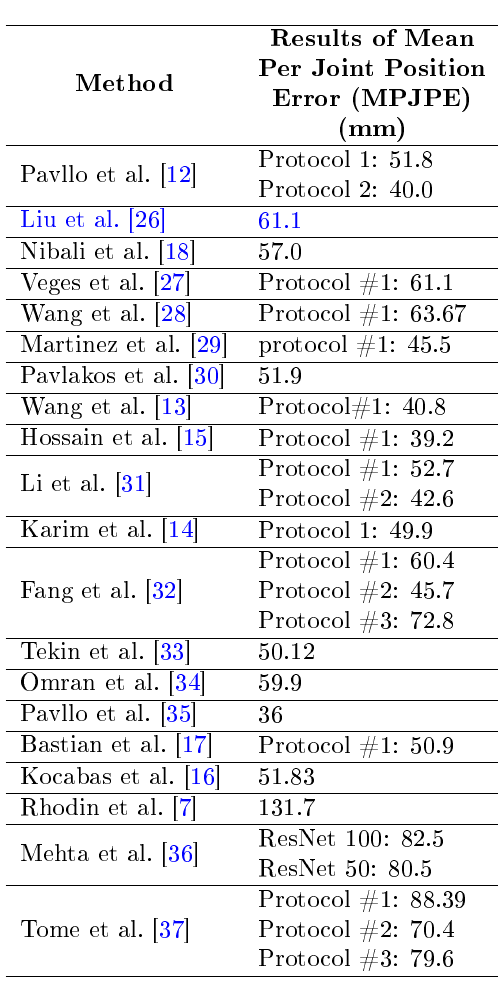
Tab. 1: Statistics of the result of studies based on the MPJPE(mm) measurement on the Human3.6m dataset [2] for 3-D human pose